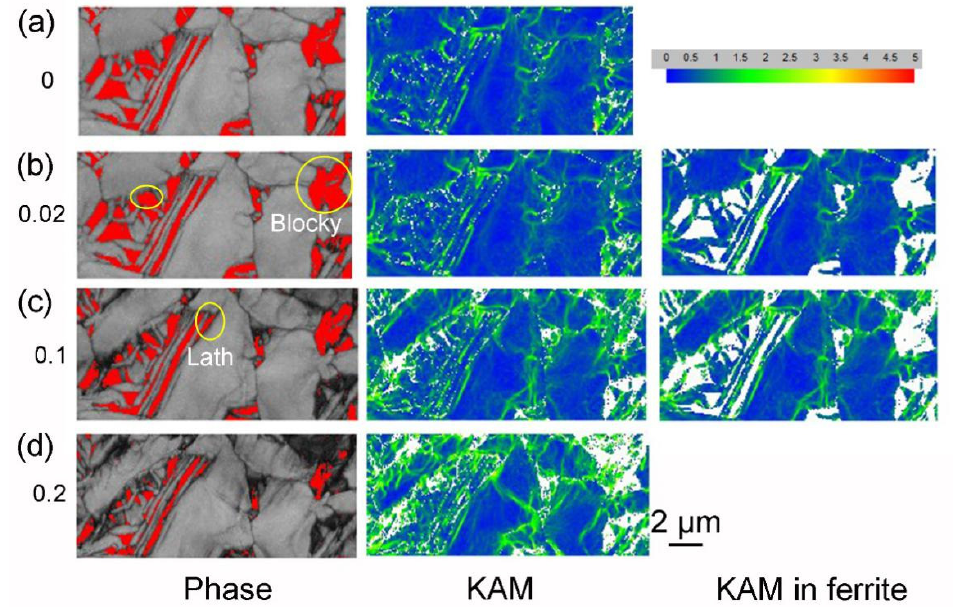
Figure 9. The EBSD phase maps, KAM maps, and KAM in ferrite maps of 1 Mn steel at different engineering strain of ( a ) 0, ( b ) 0.02, ( c ) 0.1 and ( d ) 0.2.